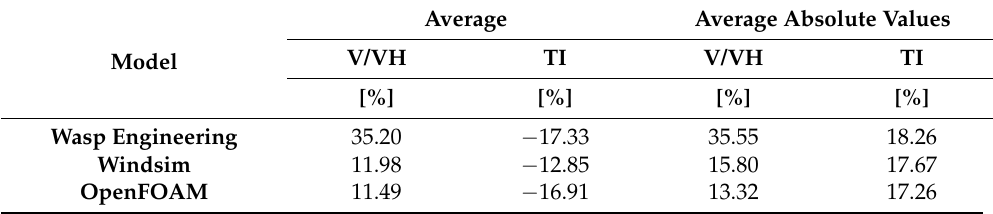
layer achieved by the model (VH); TI is the turbulence